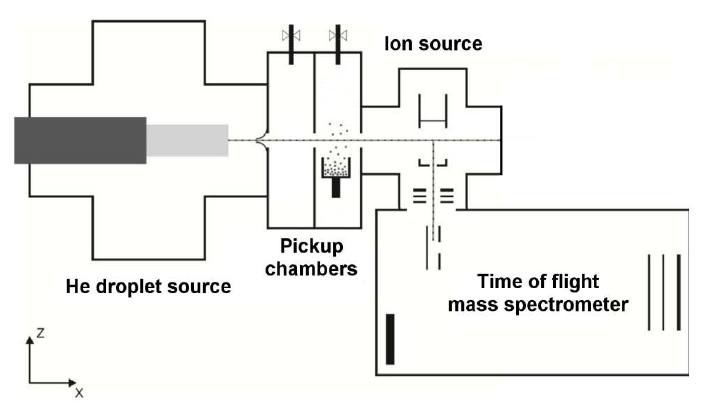
Figure 1. Schematic illustration of the experimental setup. Calcium vapor is picked up by neutral helium nanodroplets that are formed by expansion of precooled and pressurized helium into vacuum. The doped helium nanodroplets are ionized via electron impact and all product ions ejected from the heavy droplets are analyzed by a reflectron time-of-flight mass